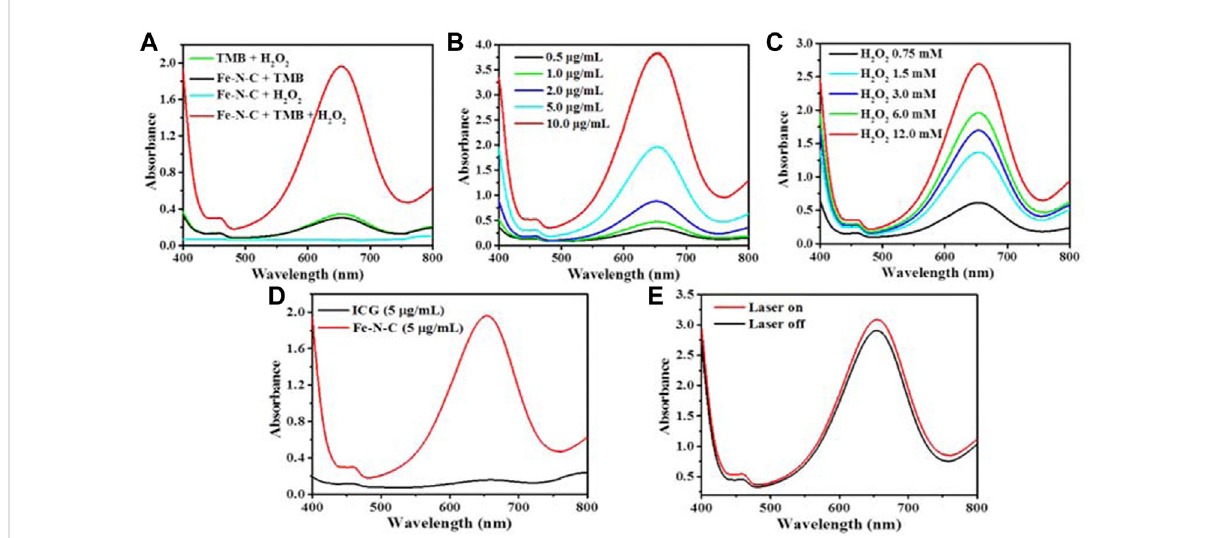
FIGURE 4 (cid:129) OH generation by Fe-N-C SAzymes. (A) Detection of peroxidase (POD)-like activityof Fe-N-C (5 μ g/ml) throughcolorimetric The capacity of assays of TMB as substrate (within 120 s) by UV-Vis-NIR absorption spectra at 652 nm. (B) UV-vis absorption spectra for the various concentrations of Fe-N-C at the same concentration of H 2 O 2 (3 mM). (C) UV-vis absorption spectra for the generation of (5 μ g/ml) with various concentrations of H 2 O 2 . (D) Comparison of peroxidase (POD)-like activity of Fe-N-C and ICG through chromogenic assay of TMB as substrate (within 120 s) at the same concentration. (E) Peroxidase-like activity with or without NIR laser irradiation at the same concentration of Fe-N-C (5 μ g/ml). Data are representative of two independent